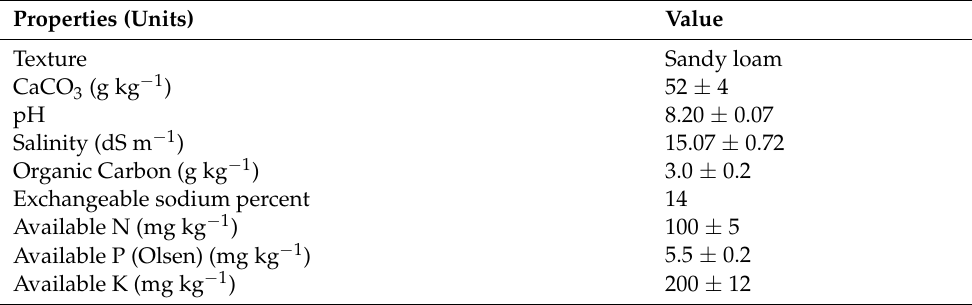
Table 1. Basic properties of the studied soil and